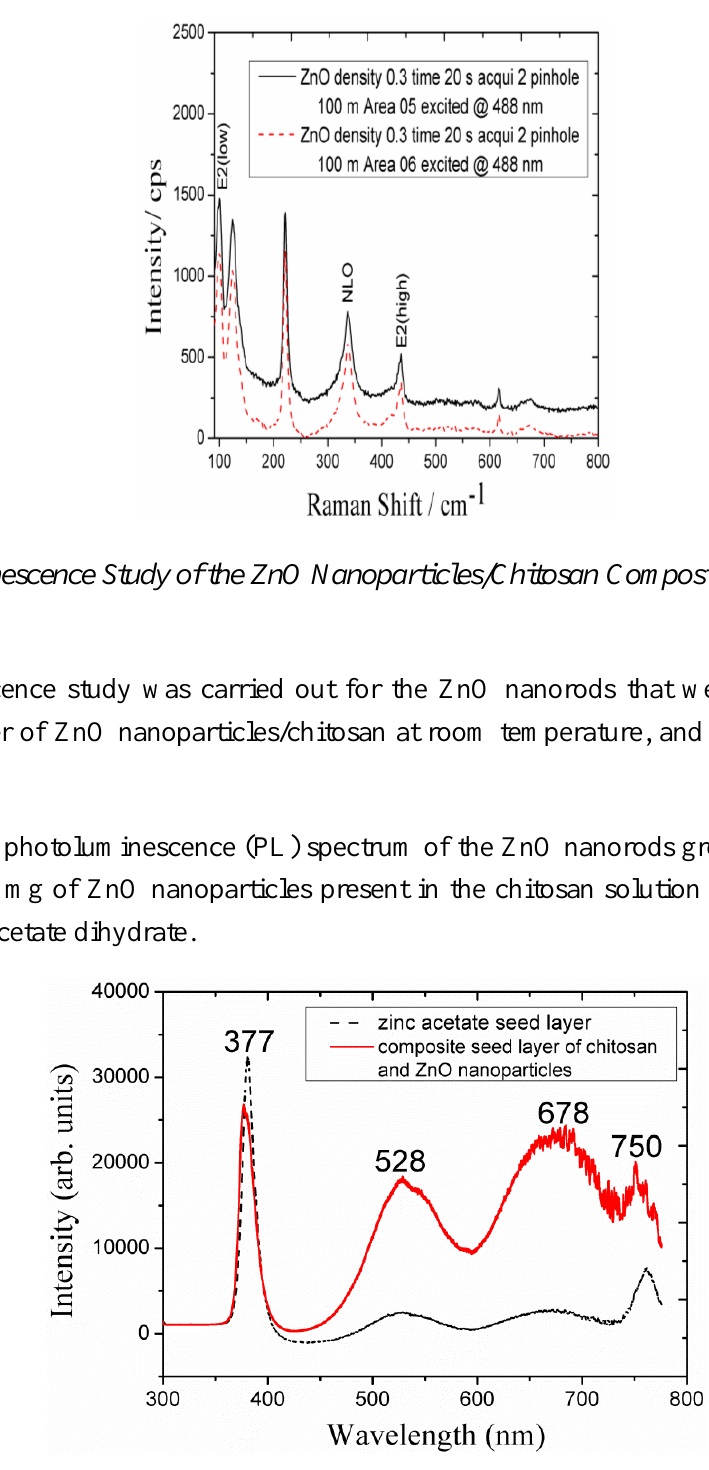
Figure 6. The Raman spectrum of the ZnO nanoparticles at room temperature at 488